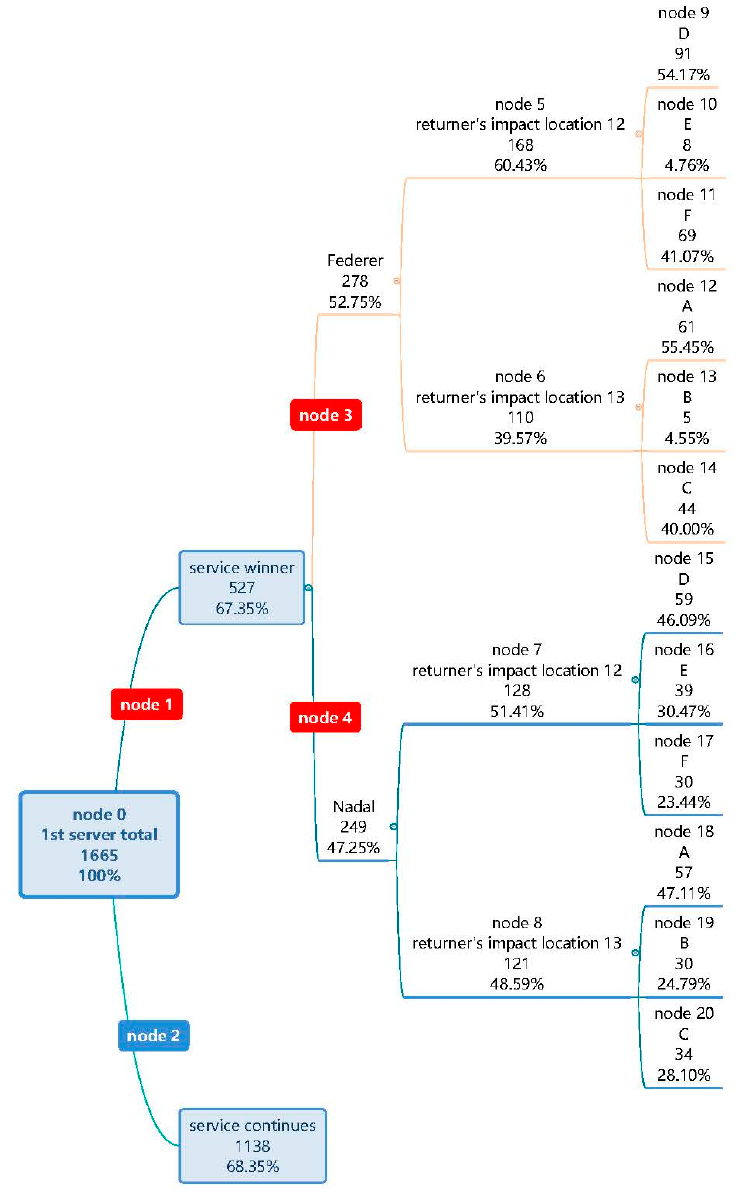
Figure 4. Classification results for first serves obtained by decision tree